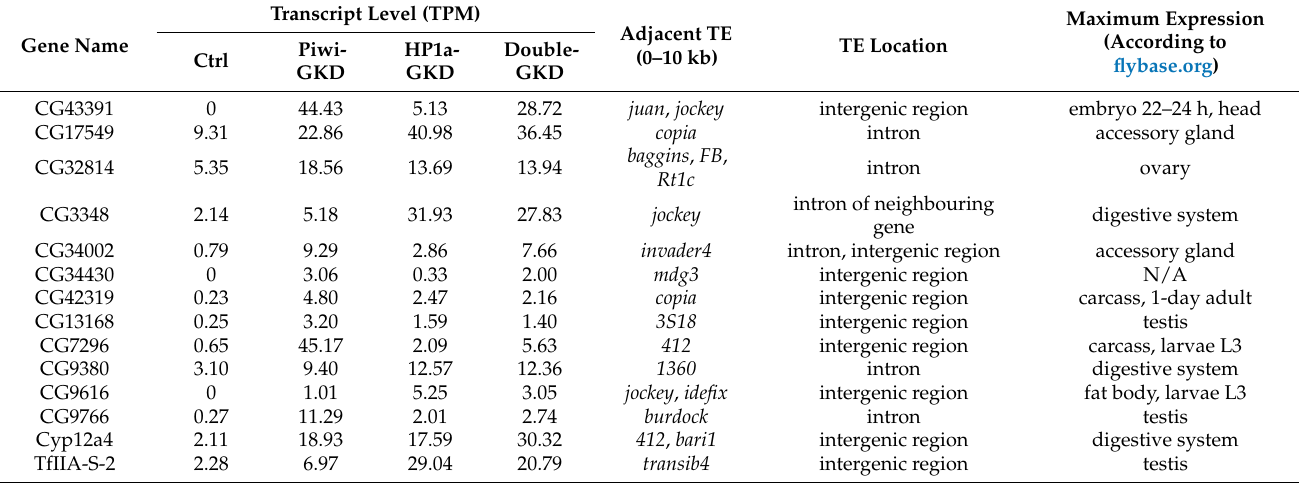
Table 1. List of genes adjacent to TE insertions (up to 10kb) and upregulated >2-fold upon Piwi and HP1a